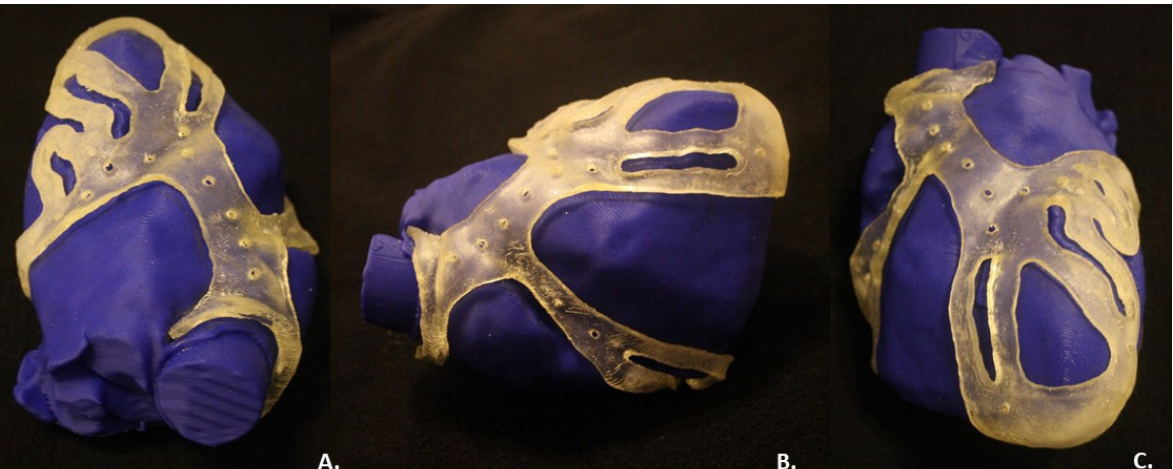
a thickness of 3.5 mm.